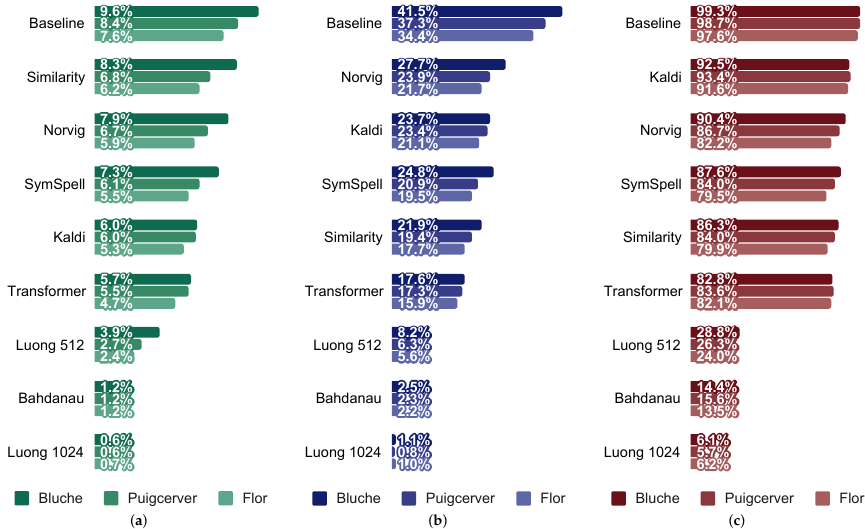
Figure 18. Error rates in the Saint Gall dataset (lower is better), ( a ) Character Error Rate (CER); ( b ) Word Error Rate (WER); ( c ) Sequence Error Rate